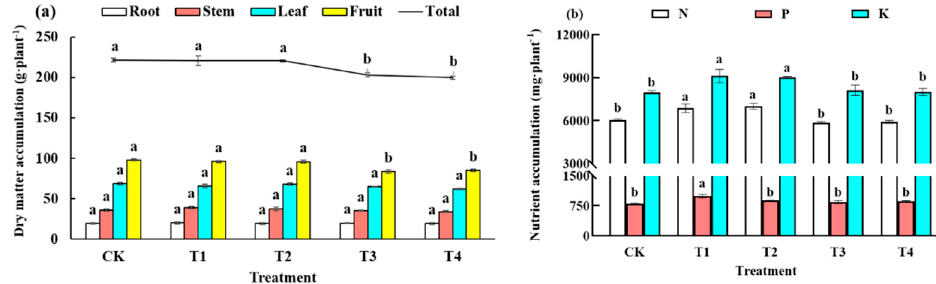
Figure 2. Effects of reduced fertiliser application before harvesting on plant biomass and element accumulation. ( a ) represents the dry-matter accumulation in the roots, stems, leaves and fruits of plants throughout the experimental period. ( b ) represents the total accumulation of N, P and K elements in plants during the experiment. Data were tested at the end of the experiment, and they were the means of six replicates with standard error (±SE). Means followed by the same lowercase letter in the same column were not significantly different according to Tukey's multiple range test results at p of 0.05 (n = 6). With no fertiliser reduction as the control (CK), the T1, T2, T3 and T4 treatments represented 20%, 40%, 60% and 80% reduction in fertiliser application from 0 to 6 days before each harvest, respectively.